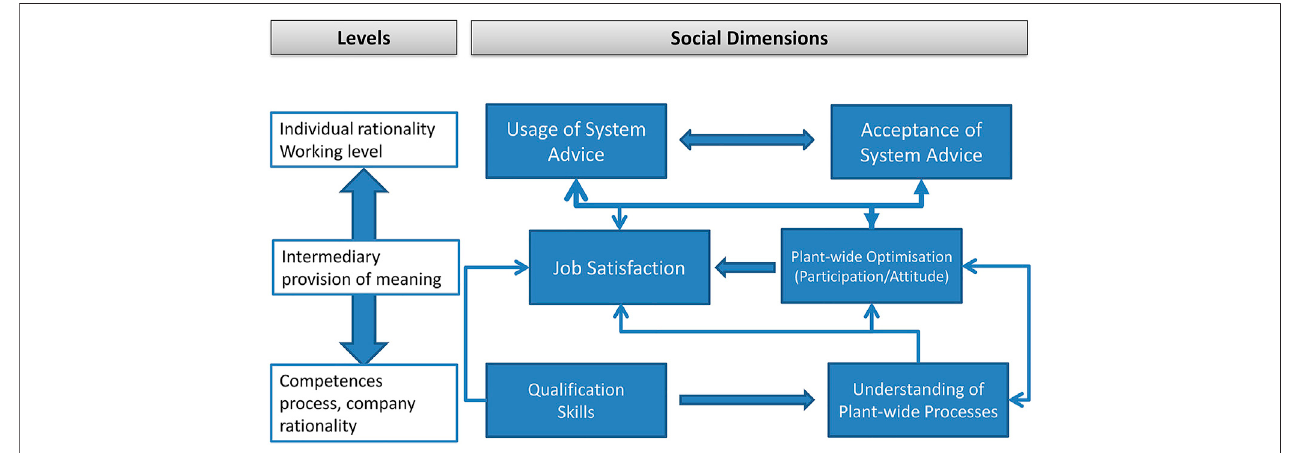
FIGURE 3 | Social Key Performance Indicators (OPT et al., 2017, p. 11, permission obtained).